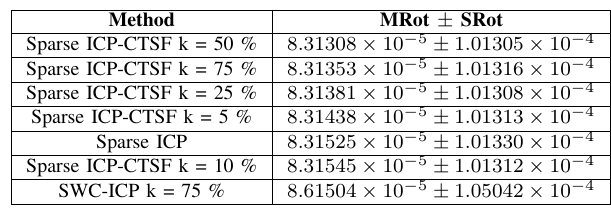
TABLE IX: Best seven methods for video ‘freiburg2 rpy’ according to the rotation average (equation (47)) with standard deviations given by expression (49).